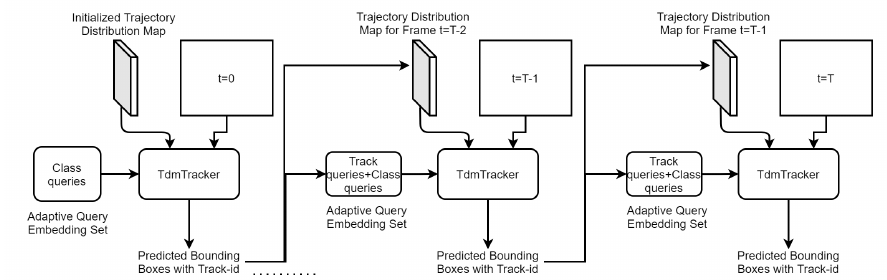
Figure 2. Tracking pipeline. The result of the previous frame is used to obtain the trajectory distribu- tion map and track queries, which are inputs for current